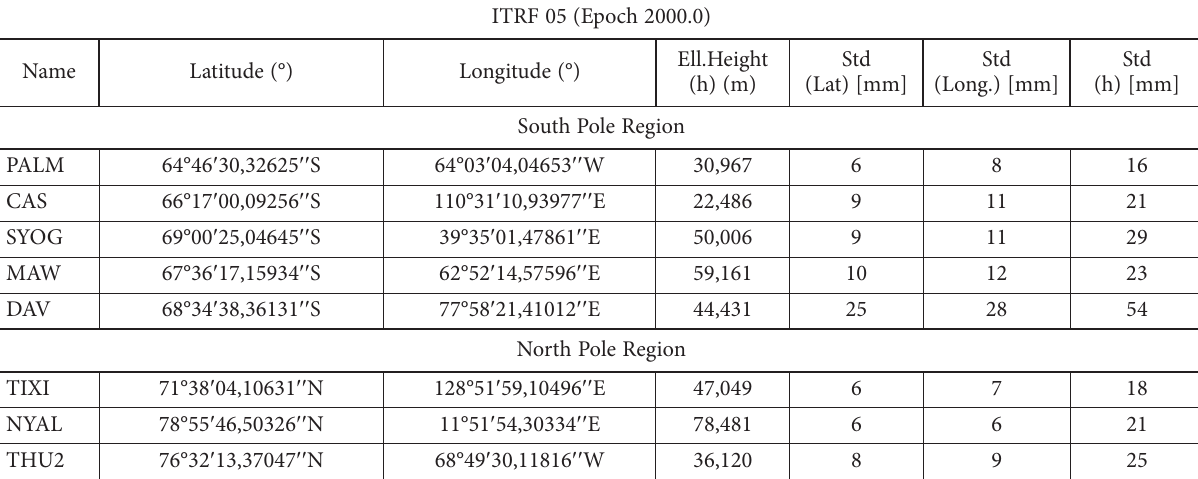
Table 1. Standard deviation and coordinate values (ITRF 05, Epoch 2000.0) of the eight IGS points by processing static GNSS satellites (CSRS-PPP Software) in the South and North Pole Region ITRF 05 (Epoch